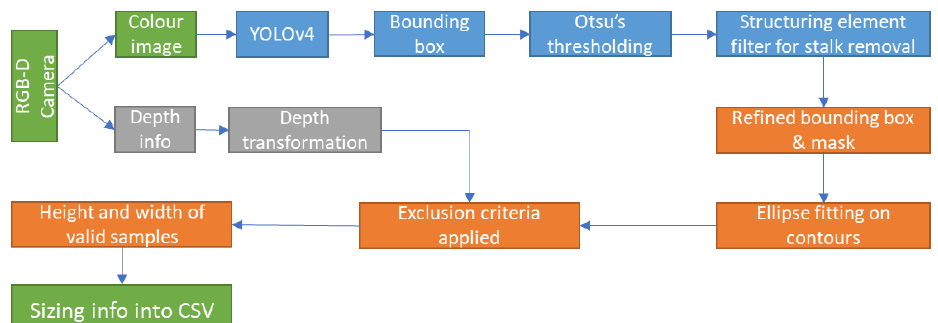
Figure 5. Method 1–Fruit sizing based on YOLOv4-tiny detection and Otsu’s thresholding. This method is an adoption of Wang et al. [9], with changes in object detector and filter for stalk removal. A Mask R-CNN model was used to segment fruit pixels on the images in two ap- proaches – (a) using the entire image (Method 2, Figure 6) and (b) using image snips de- fined by bounding boxes generated by the YOLOv4-tiny detector (Method 3, Figure 7).